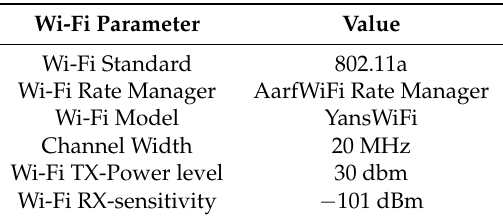
Table 2. Wi-Fi Simulation